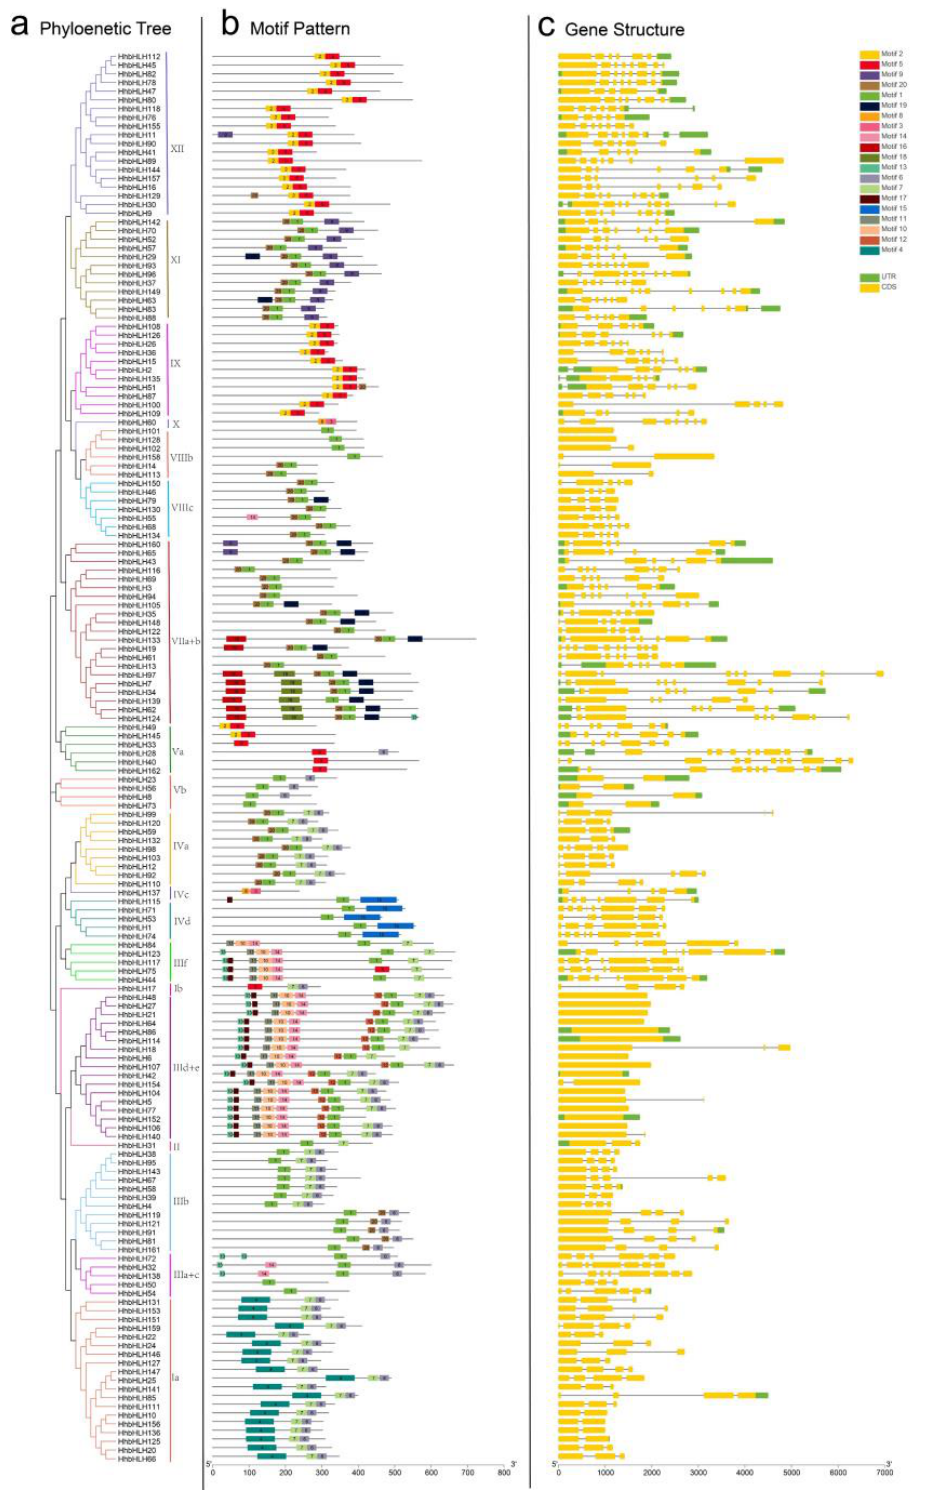
Figure 3. Phylogenetic relationships, gene structure, and architecture of conserved protein motifs in bHLH genes from H. hamabo . ( a ) The phylogenetic tree and the subfamily are shown in different colors. ( b ) The motif composition of H. hamabo bHLH proteins. ( c ) The exon-intron structure of H. hamabo bHLH